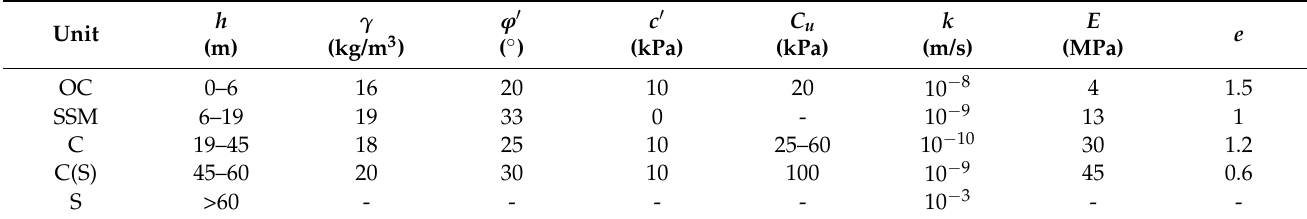
Table 1. Geotechnical design parameters.